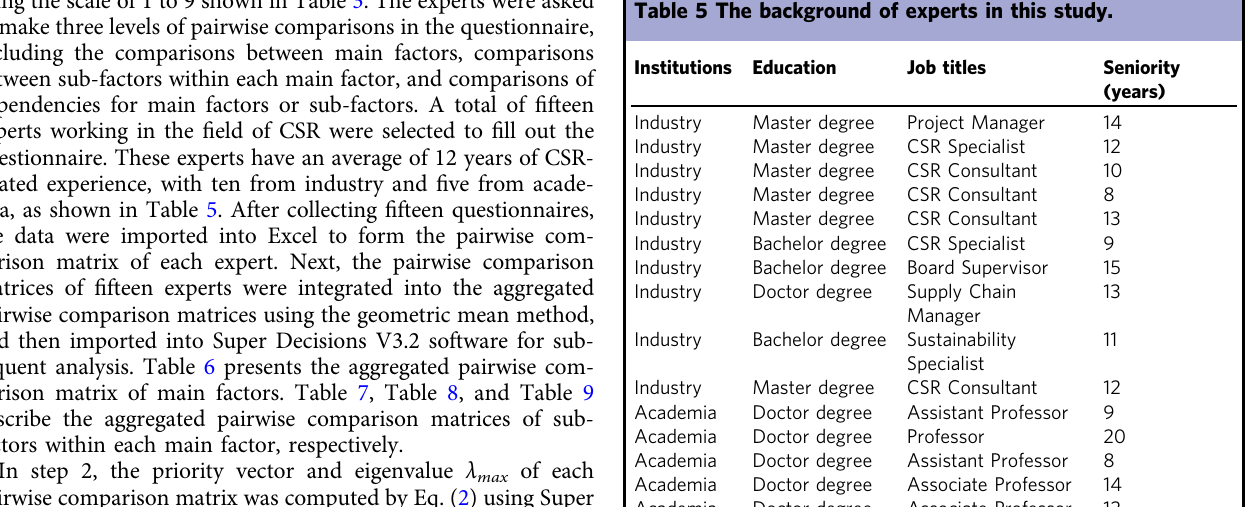
Table 5 The background of experts in this study.